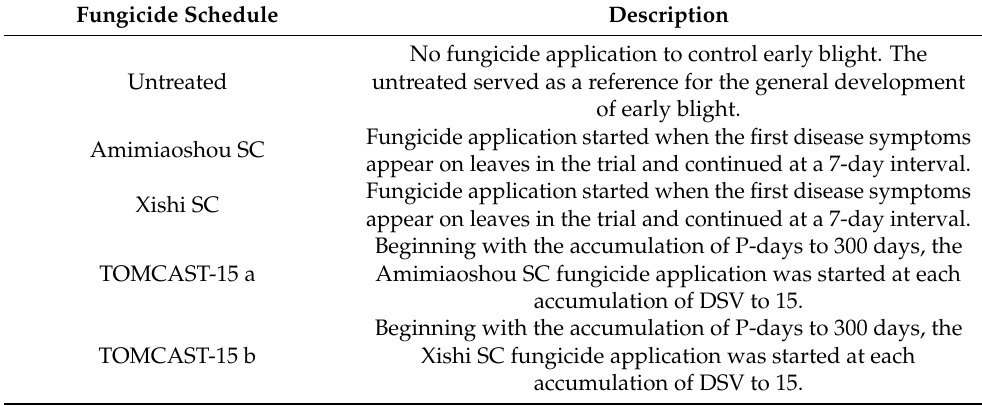
Table 6. Field operations and agronomic practices undertaken from 2020 to 2022.